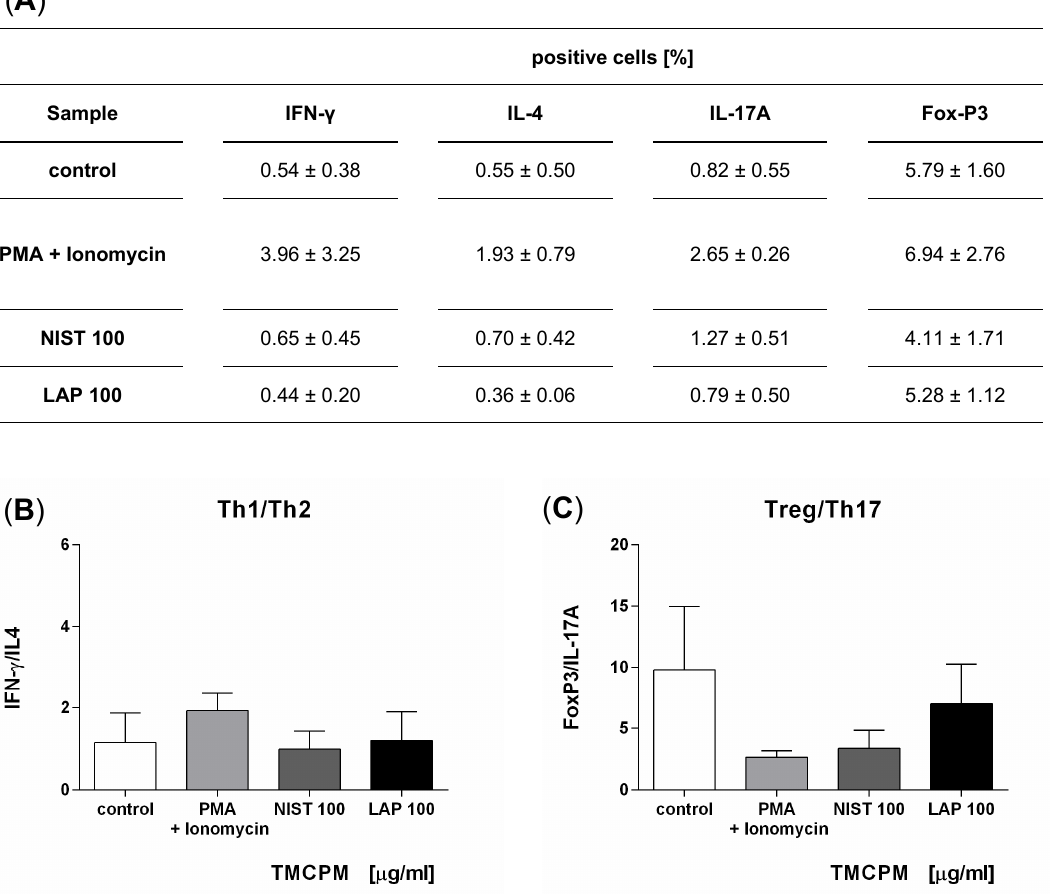
Figure 4. E ff ect of the exposition of T lymphocytes to TMCPM (NIST or LAP) on the Th1 / Th2 and Figure 4. Effect of the exposition of T lymphocytes to TMCPM (NIST or LAP) on the Th1/Th2 and Treg / Th17 ratios. T lymphocytes were stimulated with PMA (50 ng / mL) + ionomycin (100 ng / mL) Treg/Th17 ratios. T lymphocytes were stimulated with PMA (50 ng/mL) + ionomycin (100 ng/mL) (positive control) or with NIST or LAP (100 µ g / mL). Percentage of Th1, Th2, Th17, and Treg cells (positive control) or with NIST or LAP (100 μg/mL). Percentage of Th1, Th2, Th17, and Treg cells was was quantified as the frequency of cells positive for IFN- γ , IL-4, IL-17A and FoxP3, respectively ( A ). quantified as the frequency of cells positive for IFN-γ, IL-4, IL-17A and FoxP3, respectively ( A ). The The frequency ratio (%) of IFN- γ positive to IL-4 positive CD4 + T cells (Th1 / Th2) ( B ) and FoxP3 positive frequency ratio (%) of IFN-γ positive to IL-4 positive CD4+ T cells (Th1/Th2) ( B ) and FoxP3 positive to IL-17A positive CD4 + T cells (Treg / Th17) ( C ), was calculated. Data are presented as the mean ± SEM to IL-17A positive CD4+ T cells (Treg/Th17) ( C ), was calculated. Data are presented as the mean ± from three independent experiments SEM from three independent experiments performed.